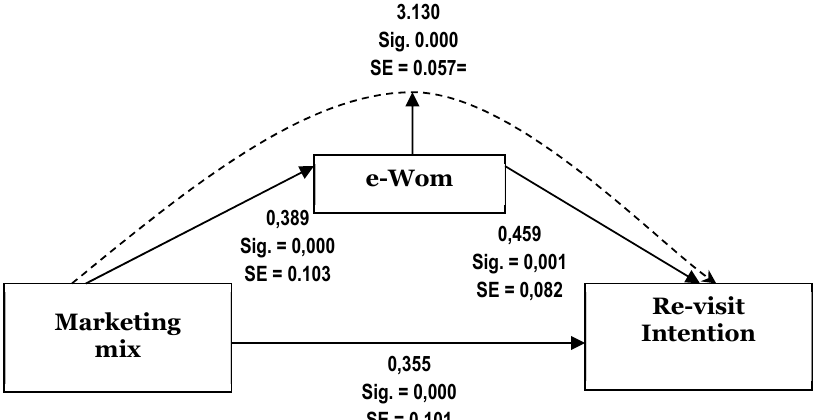
Fig. 3. The results of the analysis of the path of direct influence and indirect influence (marketing mix, e-WOM, and revisit